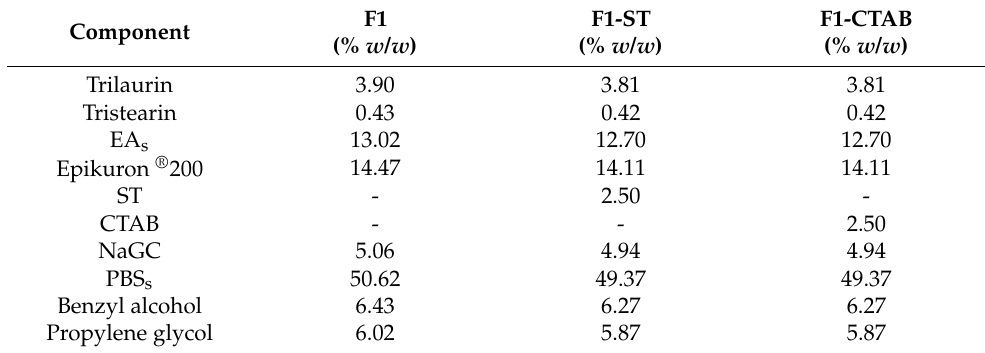
Table 4. Microemulsion